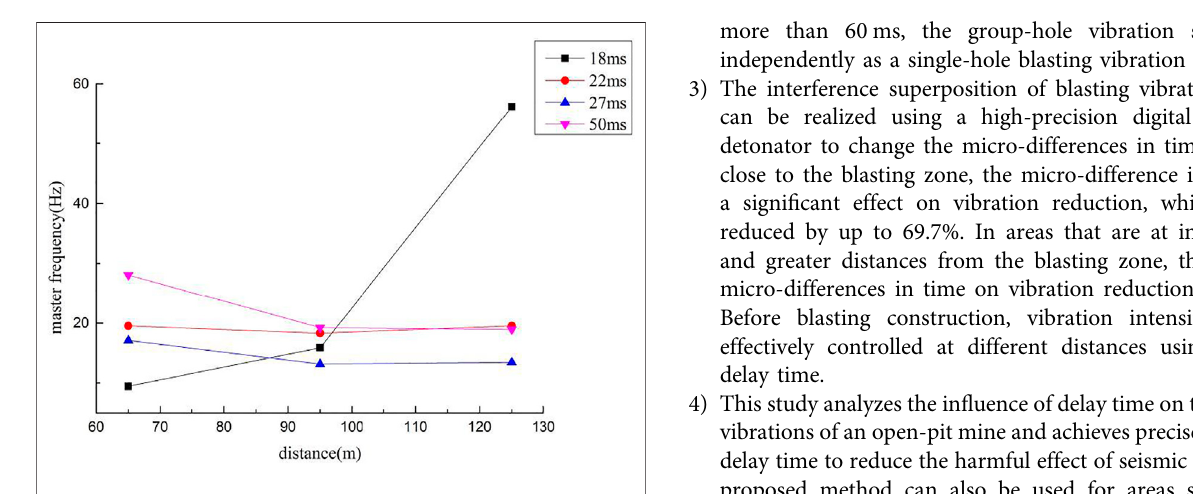
FIGURE 9 | Main frequency of each measuring point at different delay